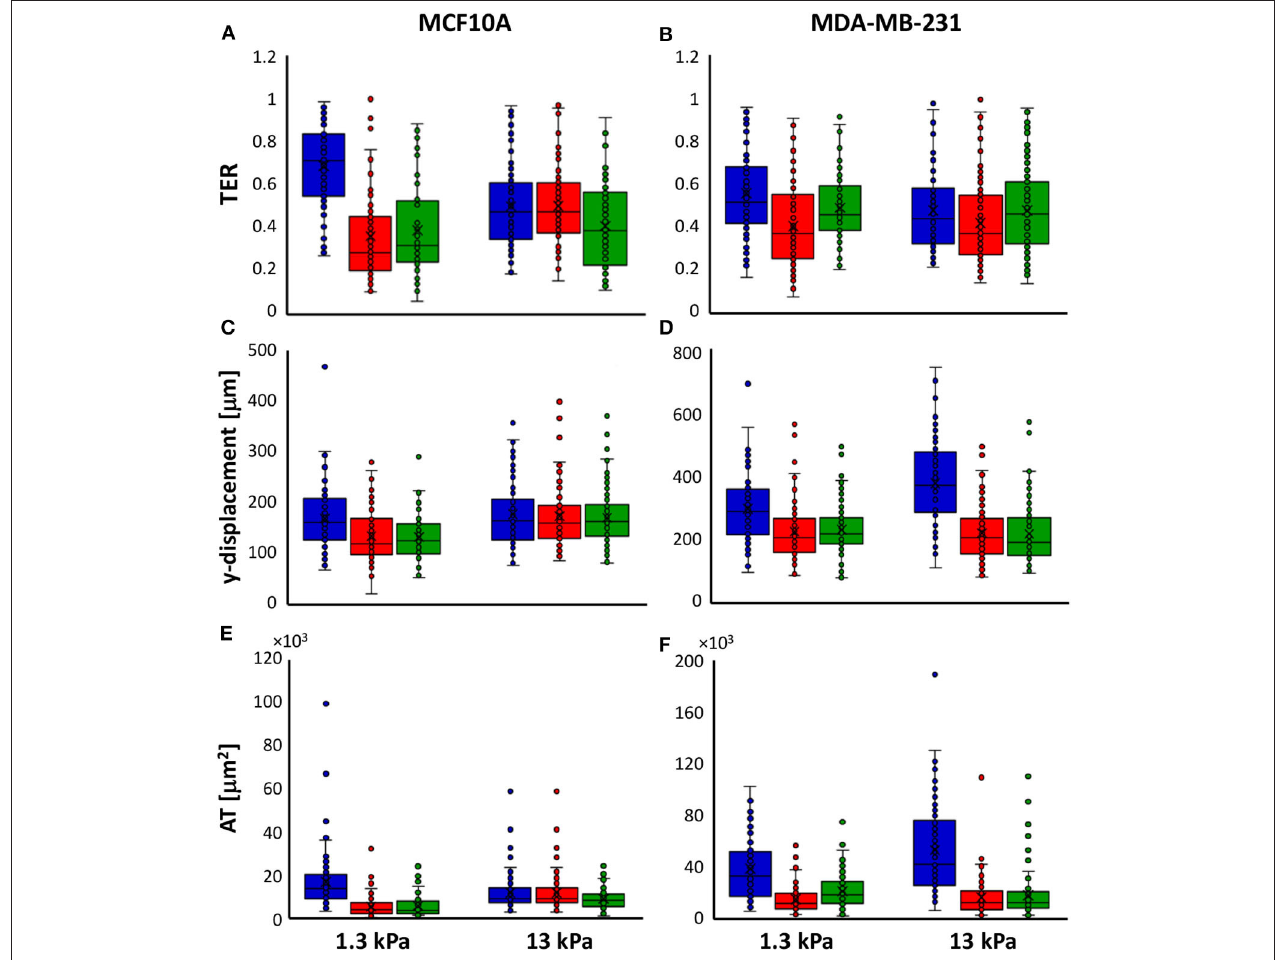
FIGURE 2 | Box plots (mean, median, interquartile range, and outliers) of TER (A,B) , y-displacement (C,D) and AT (E,F) parameters of MCF10A (A–E) and MDA-MB-231 cells (B–F) in control condition (blue) and 72h after irradiation with doses of 2Gy (red) and 10Gy (green). n > 58 for MCF10A cells, n > 82 for MDA-MB-231